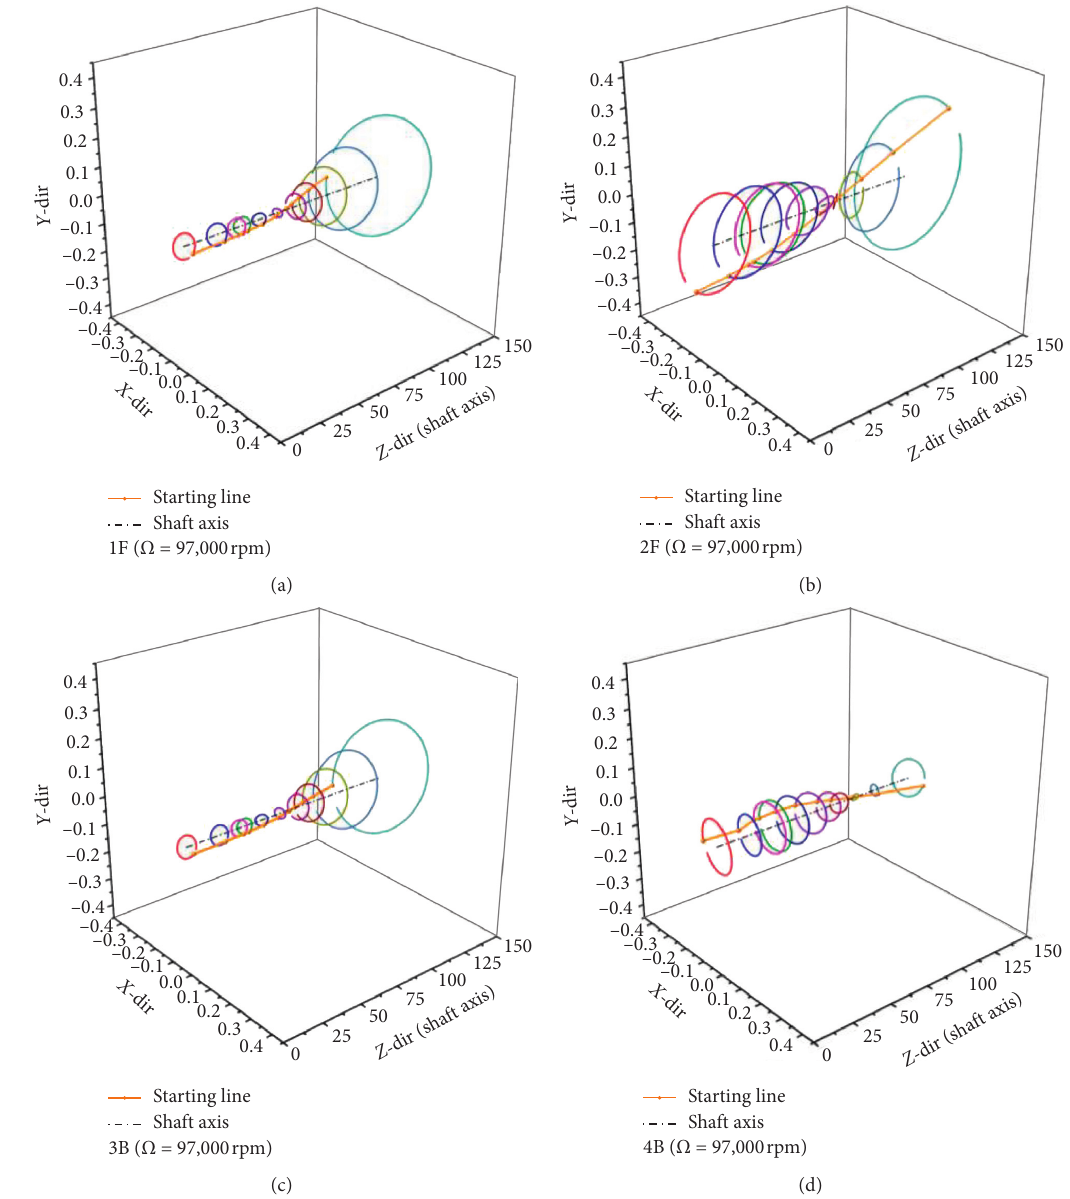
Figure 18: Mode shapes at 97,000rpm (SLS 2). (a) Mode 1F. (b) Mode 2F. (c) Mode 3B. (d) Mode